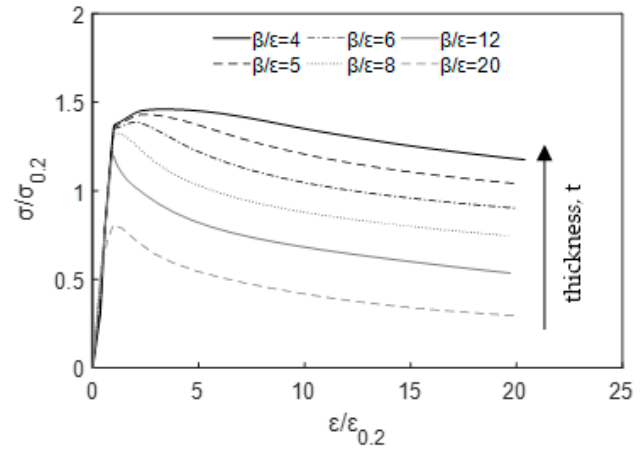
Figure 7. Typical normalised stress-strain responses for 6082-T6 cross-sections with a / b = 1.0 and different slenderness β / ε .